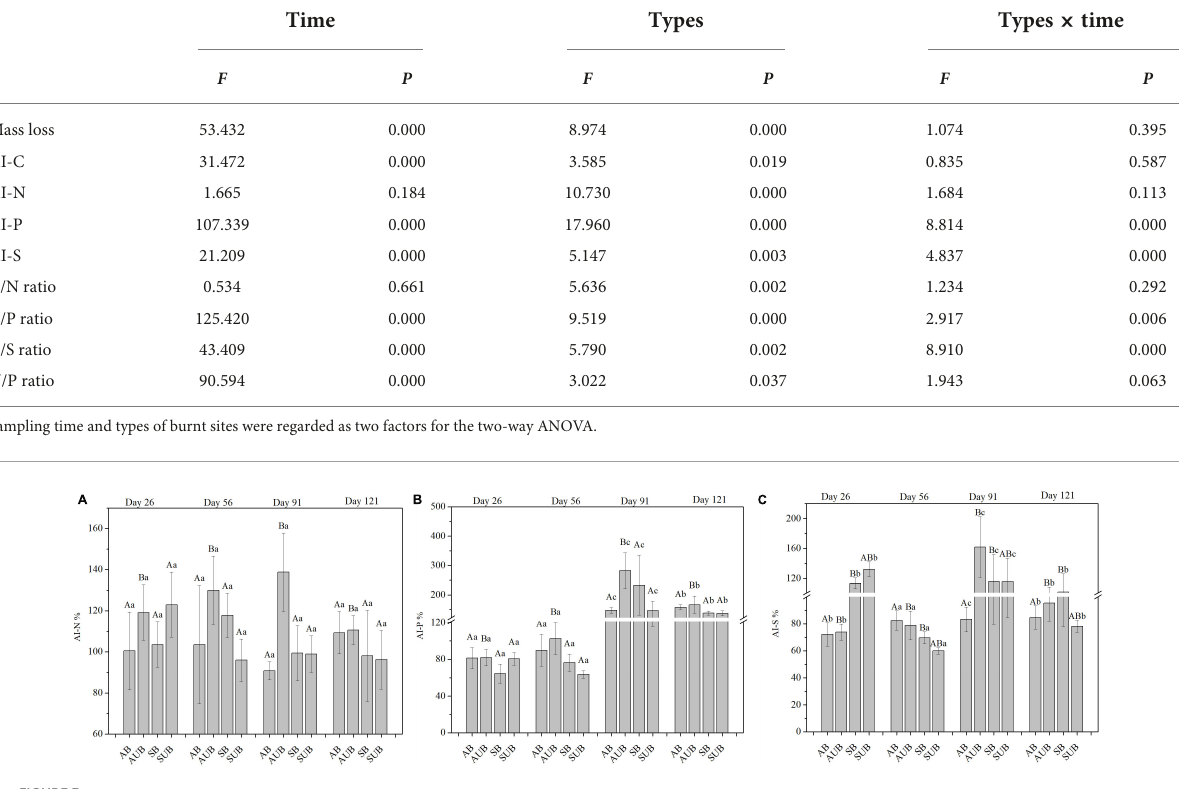
FIGURE3 The AI-N (A) , AI-P (B) , and AI-S (C) in residual plant litters in autumn burnt (AB), autumn unburnt (AUB), spring burnt (SB), and spring unburnt (SUB) sites. Different lowercase letters (a-c) indicate significant differences (Tukey-HSD test) among sampling times and different uppercase letters (A-B) indicate significant differences (Tukey-HSD test) between site